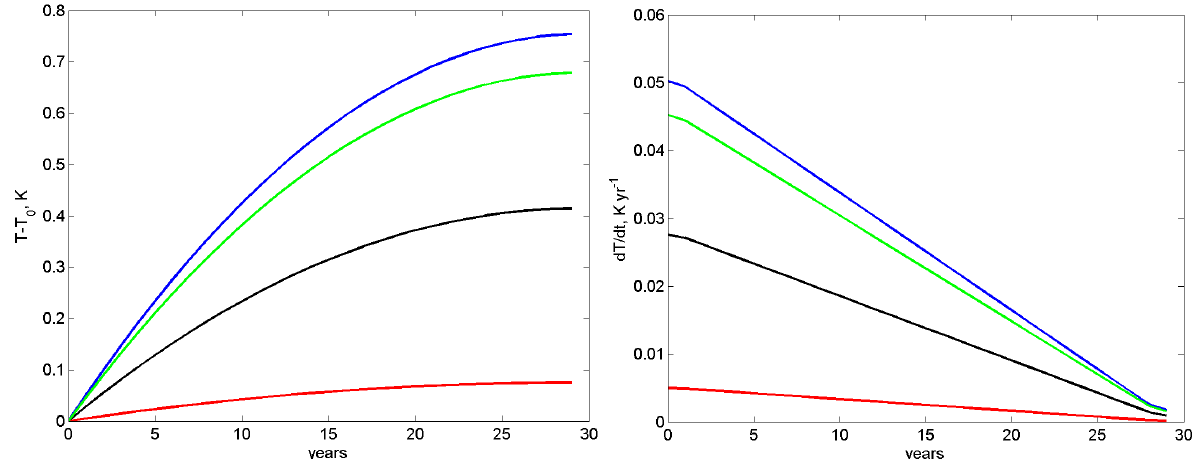
Figure 1. Response (a) of the temperature after Eq. (1) and its change rate (b) on an instant perturbation of the temperature flux by the observed green-house gas forcing. The constant c T 0 = 1000 has been chosen in the way to bring the mean temperature change close to the observed one over the last 30 years. The black line denotes the mean temperature 0.5 ( T max + T min ); the blue line – the minimum temperature T min ; the red line – the maximum temperature T max ; the green line – the diurnal temperature range change ( T min − T max ). The initial state has been subtracted for all